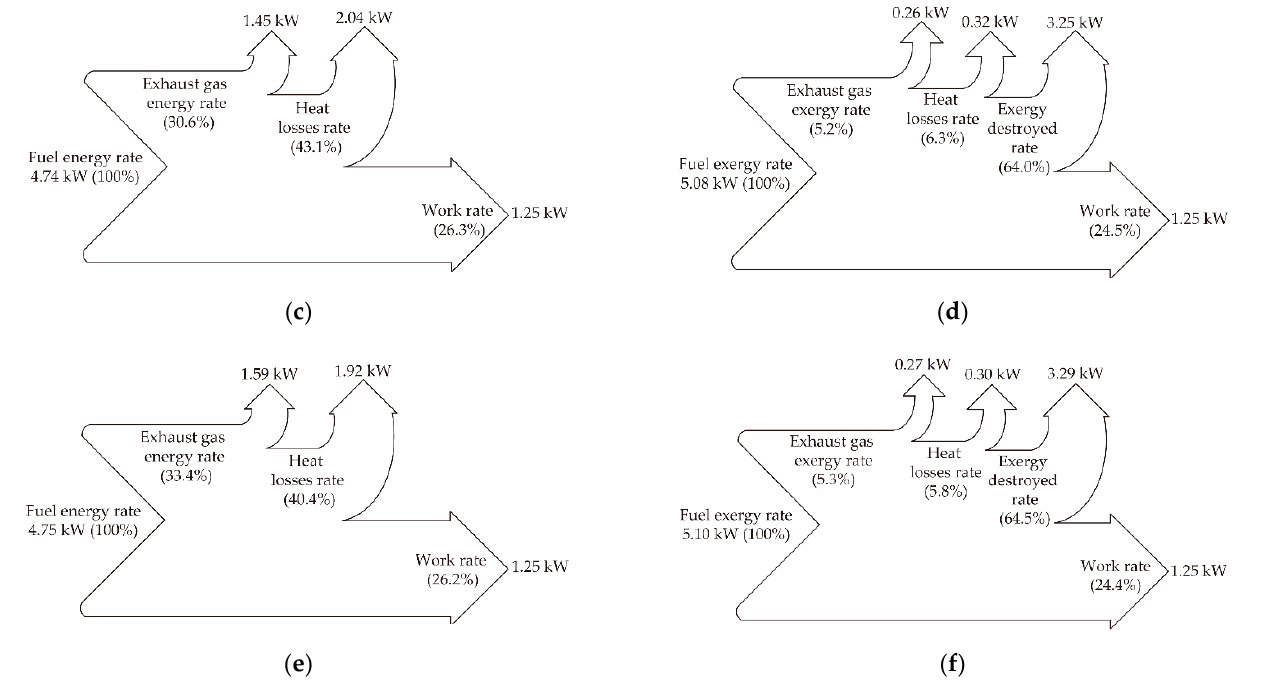
Figure 8. Energy flow (Sankey) diagrams on the left side and exergy flow (Grossman) diagrams on the right side showing the comparison of energy and exergy efficiencies of the engine fueled with ( a , b ) diesel; ( c , d ) E15B35D50; ( e , f ) E15B35FTD50.